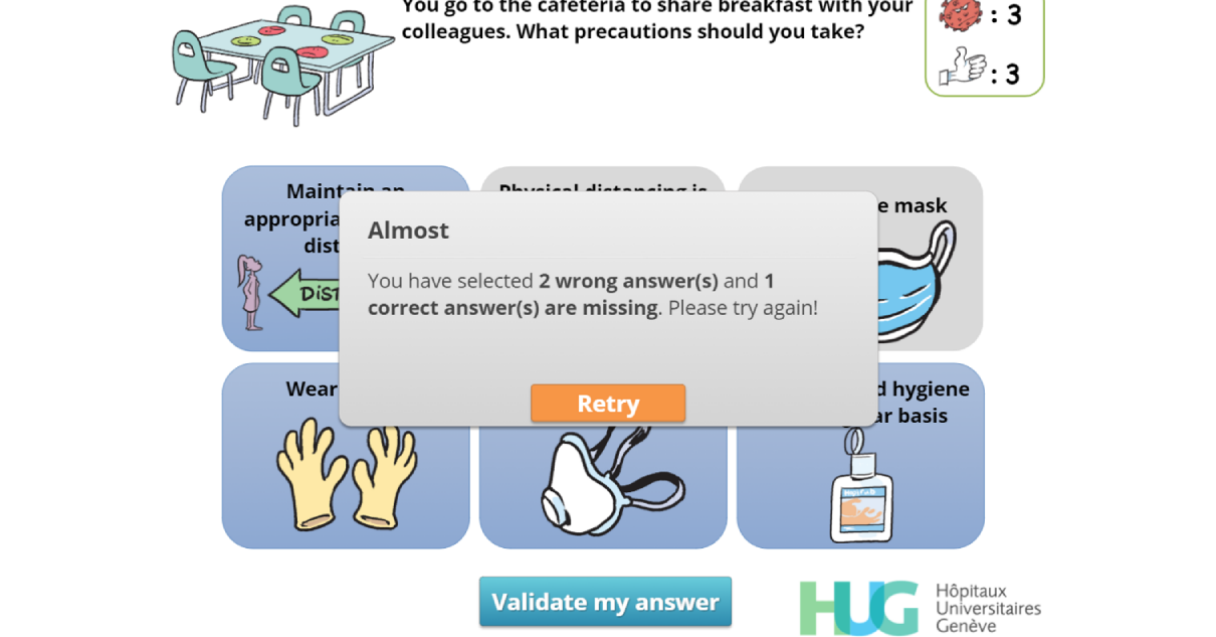
Figure 14. Feedback. The player has failed to choose the expected answers at the first try and can click on “Retry” (retry) to have a second (and last) chance. The number of wrong answers is provided along with the number of correct answers missing from the original